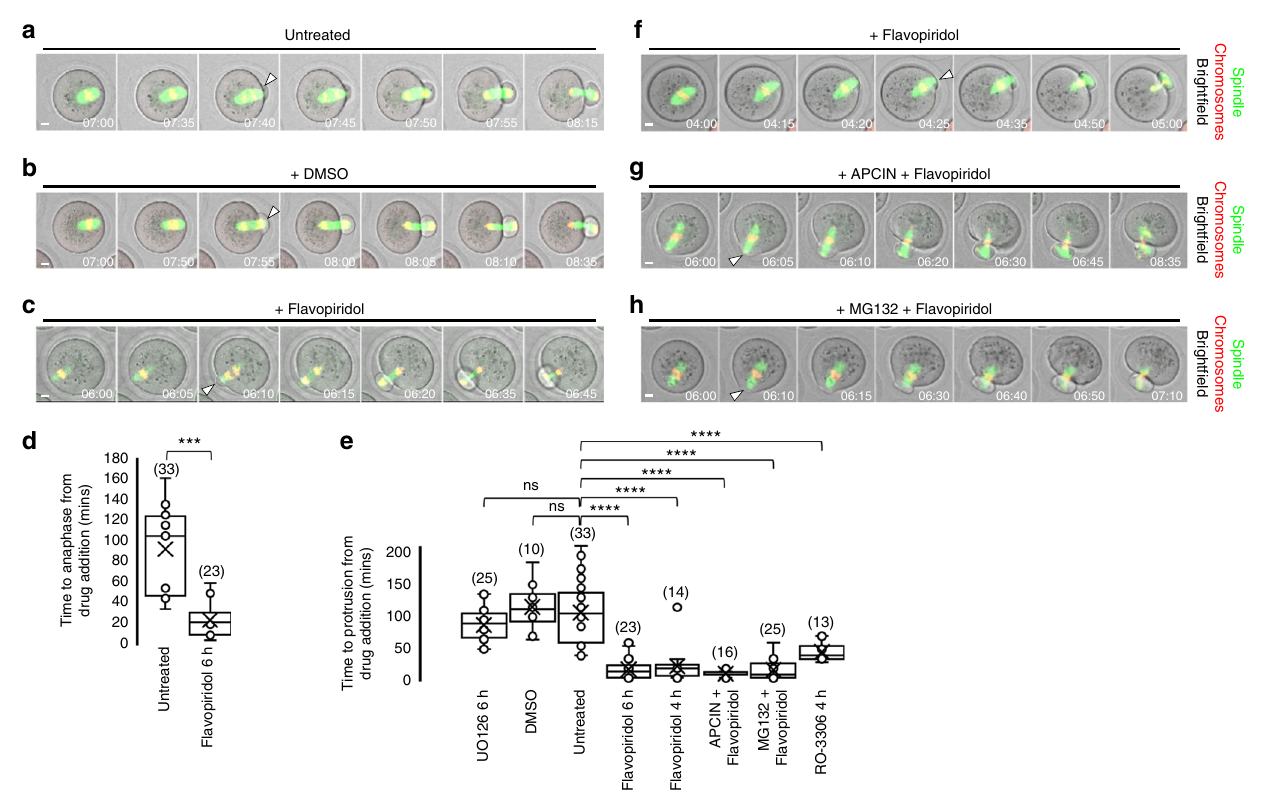
Fig. 2 Protrusion requires Cdk1 inactivation but not proteolysis. a – e Flavopiridol-induced Cdk1 inactivation accelerates anaphase and protrusion-onset. Oocytes were untreated ( a ; see Supplementary Movie 7) or treated with DMSO ( b ; see Supplementary Movie 8) or fl avopiridol ( c ; see Supplementary Movie 9) from 6 h post-GVBD. Quanti fi cation of time of anaphase-onset ( d ) and protrusion-onset ( e ). Two-tailed Student ’ s t test ( d ) or one-way ANOVA ( e ) used for statistical analysis. P values represented as *** P < 0.001 and **** P < 0.0001, ns denoted P > 0.05. Box plots depict median (horizontal line), mean (crosses), 25th and 75th percentiles (boxes) and 5th and 95th percentiles (whiskers). f – h Flavopiridol induces protrusion despite lack of proteolysis. Oocytes were treated either with fl avopiridol prior to proteolysis onset (see Supplementary Figure 6) ( f ; see Supplementary Movie 10) or with the APC- inhibitor, APCIN, followed by fl avopiridol ( g ; see Supplementary Movie 11) or the 26S proteasome inhibitor, MG132, followed by fl avopiridol ( h ; see Supplementary Movie 12). Anaphase failure re fl ects lack of proteolysis resulting in chromosome entrapment within the furrow. Times in panels are